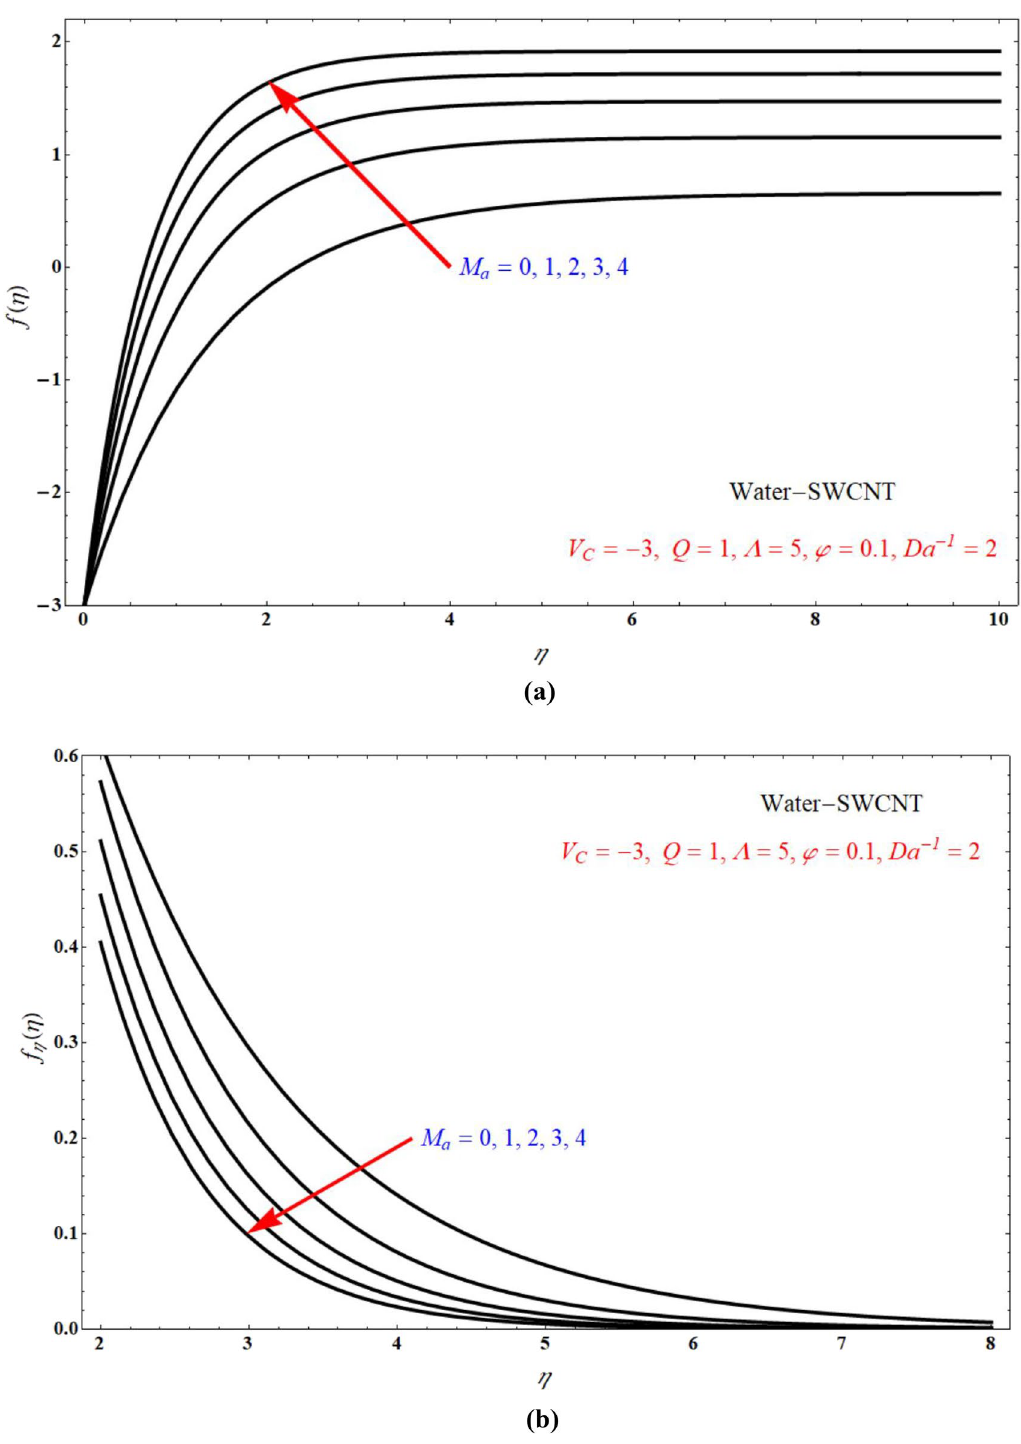
Figure 9. The plots of ( a ) f (η) verses η and ( b ) f η (η) verses η for different choices of M a at injection